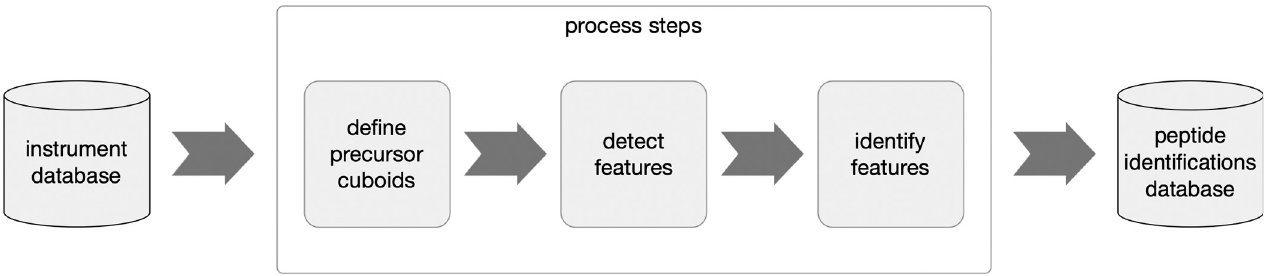
Fig 1. The high-level flow of the pipeline steps to process raw timsTOF data and identify peptide sequences.